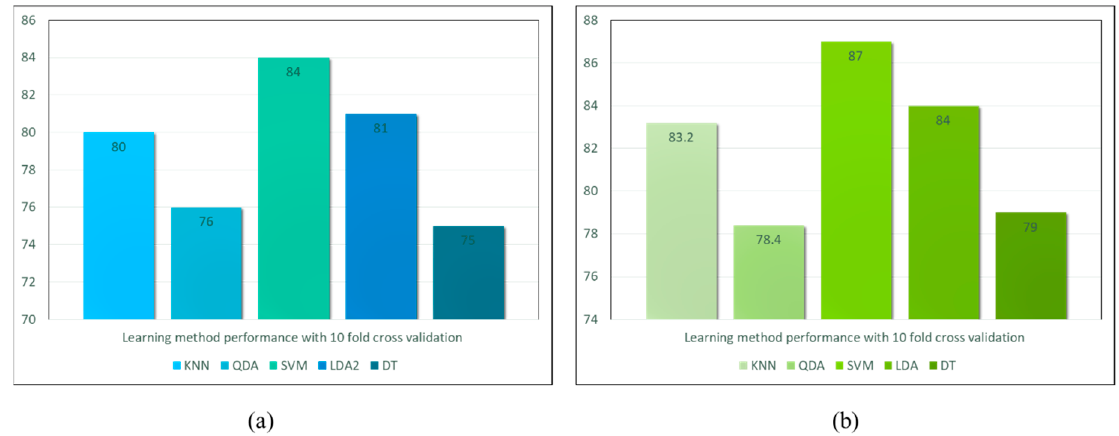
Figure 17. The performance results of different learning methods for Cleveland heart disease dataset ( a ) shows the accuracies with unprocessed data ( b ) shows the accuracies with processed data. Analysis with Diabetes Dataset